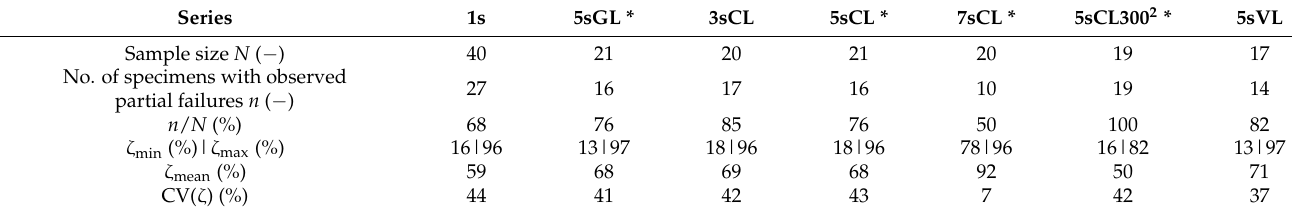
Table 6. Main statistics from partial failure